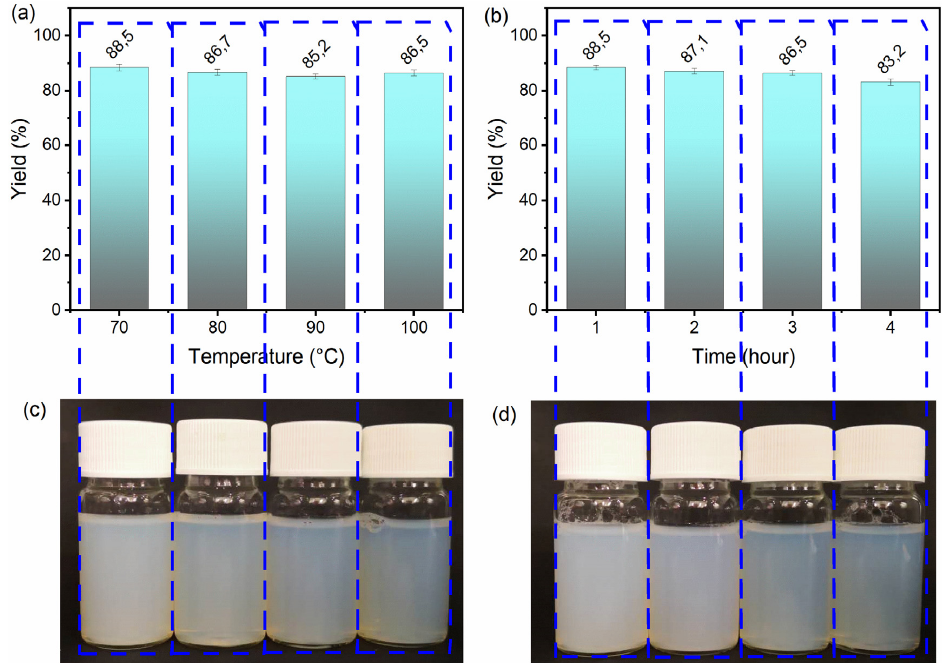
Figure 1. Mass yield of ChNCs after DES treatment (and ultrasonication) at different temperatures (3-h treatment) ( a ) and for different reaction time (at 100 °C) ( b ) and the appearance of the corresponding suspensions ( c , d ).